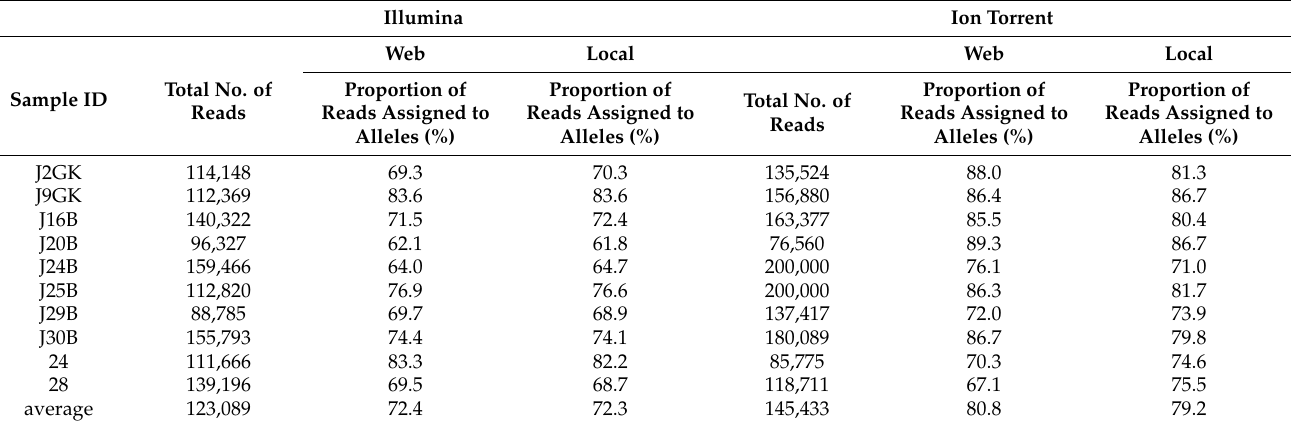
Table 4. The number of reads per sample generated with Illumina and Ion Torrent sequencing of MHC-DRB in red deer after AmpliCLEAN filtering and the proportion of reads assigned to alleles. After size and quality filtering, Illumina generated 1,227,184 and Ion Torrent generated 1,539,341 reads in